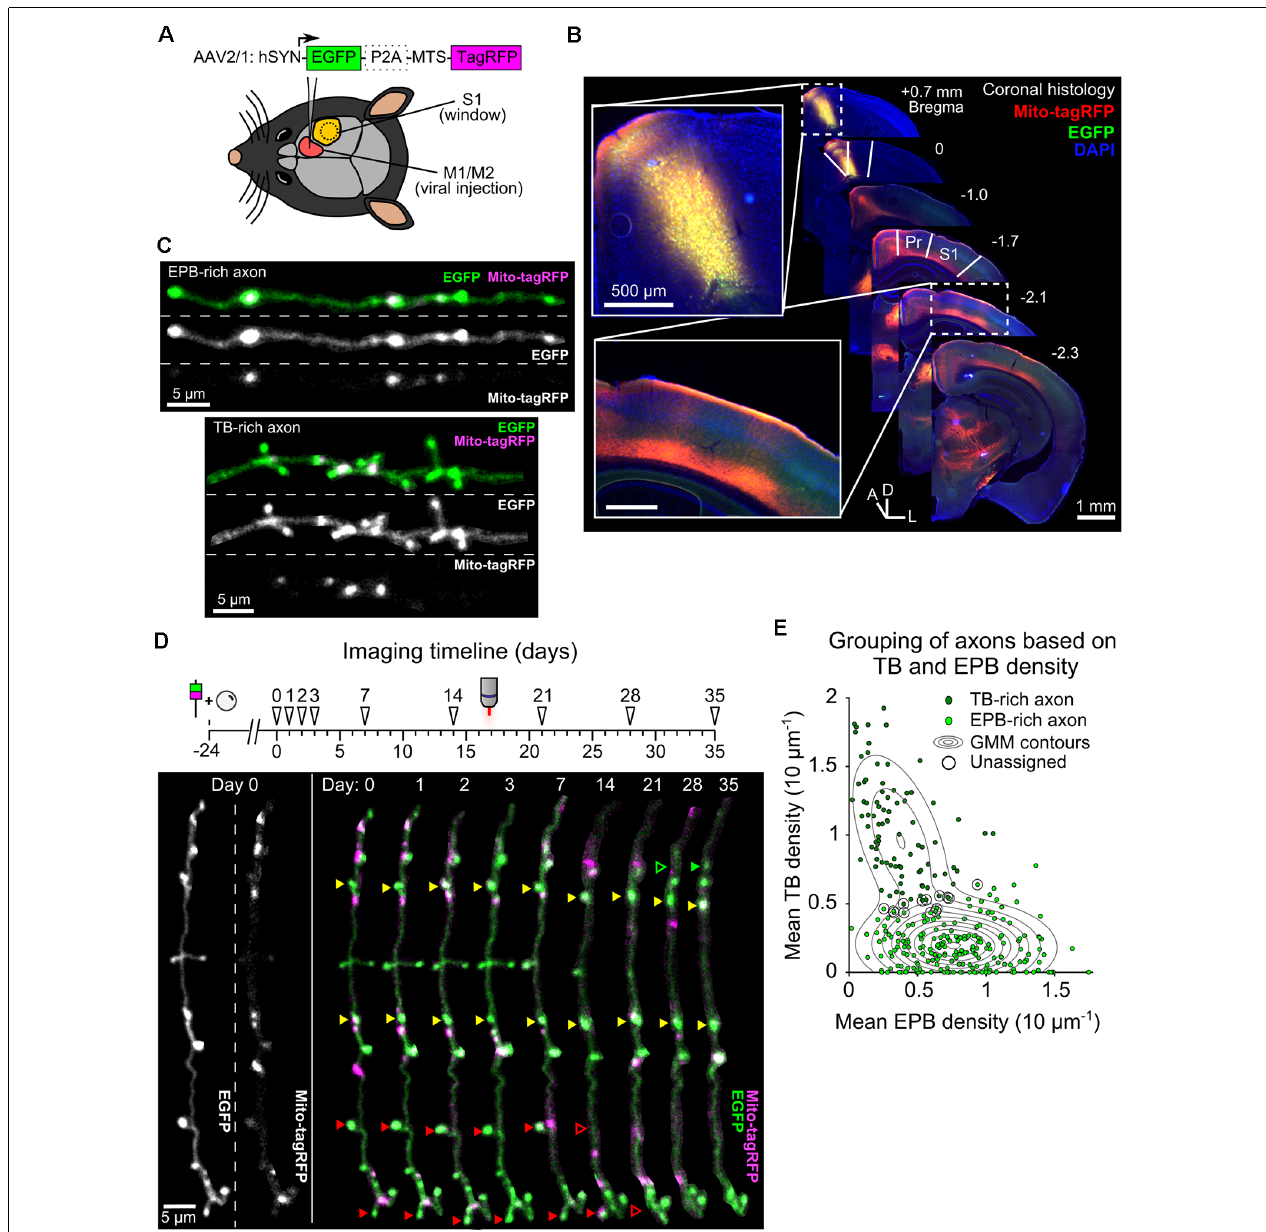
FIGURE 1 | Tracking bouton plasticity and mitochondrial positioning in axons of motor cortex neurons. (A) Adeno-associated virus (AAV) expressing cytosolic EGFP and a mitochondrial targeting sequence (MTS) conjugated to TagRFP was injected into M1/M2 and a glass cranial window was implanted over S1. (B) A series of coronal brain slices showing the viral injection site across the M1/M2 border (inset, top) and the axonal projection site at S1 under the cranial window (inset, bottom). Only the ipsilateral half of the brain sections are shown. Pr = parietal cortex, D = dorsal, L = lateral, A = anterior. (C) Cropped two-photon (2P) images from in vivo imaging show axons with high EPB density (EPB-rich) or high TB density (TB-rich). (D) (top) Imaging timeline for tracking bouton structural plasticity bouton loss and gain. Viral injection and cranial window implantation were performed 24 days prior to initial 2P imaging. Arrowheads indicate imaging time-points. (bottom) Structure and mitochondrial localization in a single cropped axon over 35 days imaged using in vivo 2P microscopy. Some boutons are labeled with arrowheads to show examples of stable (yellow), lost (red) or gained (green) boutons. (E) Gaussian mixture modeling (GMM) was used to determine two potential populations ( EPB-rich and TB-rich axons) that result in the observed sample distribution of axonal EPB and TB densities (mean across time). Axons that had posterior probabilities below 70% were not assigned to a group ( circled ; see “Materials and Methods” section). Contour lines indicate the slope of the GMM distribution.